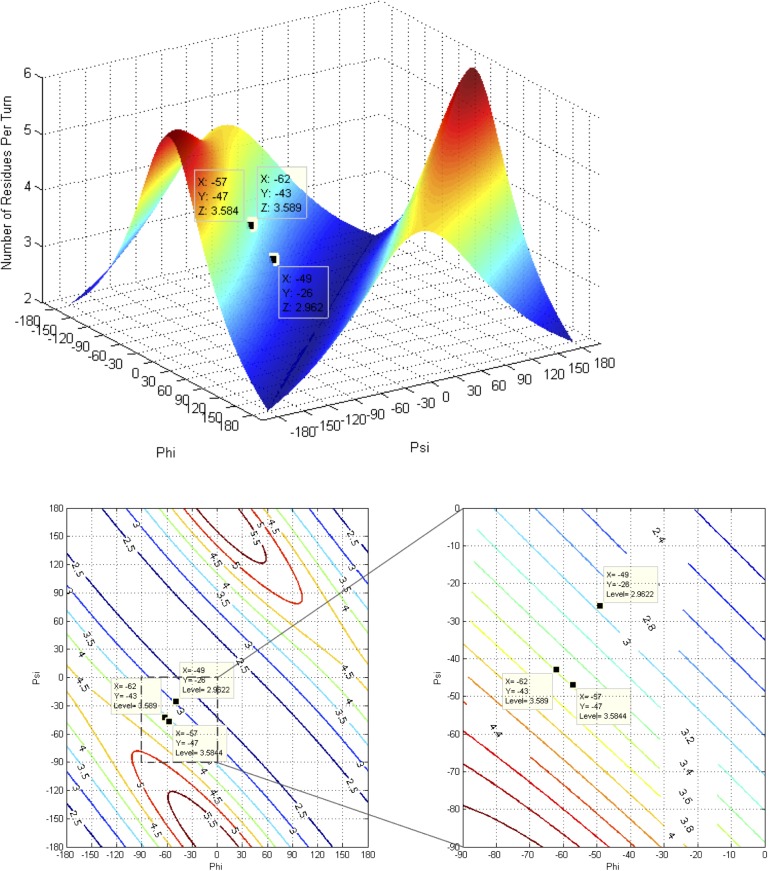
Contours and 3D surface helical pitch (n d) overlaid on 2D φ, ψ plot.Positions of classic α-helix (φ = −57, ψ = −47), 310-helix (φ = −49, ψ = −26), and experimental Némethy-, N- or 3.613/10-helix (φ = −62, ψ = −43) are indicated. Note that the helical pitch is nearly identical for the α- and 3.613/10-helices—they lie on a contour of essentially equal value.